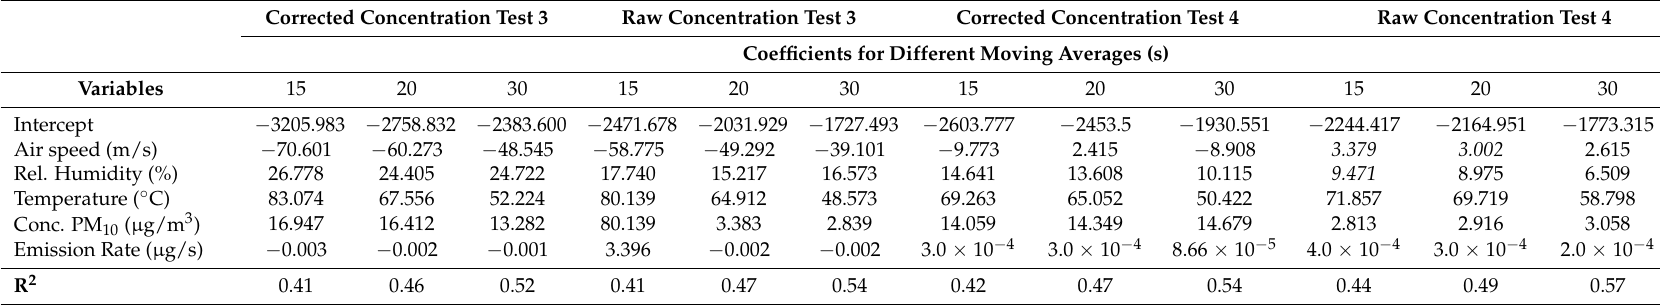
Table 6. Models generated from data collected with the TSI DRX and the collocated module using corrected concentrations and field data for Tests 3 and